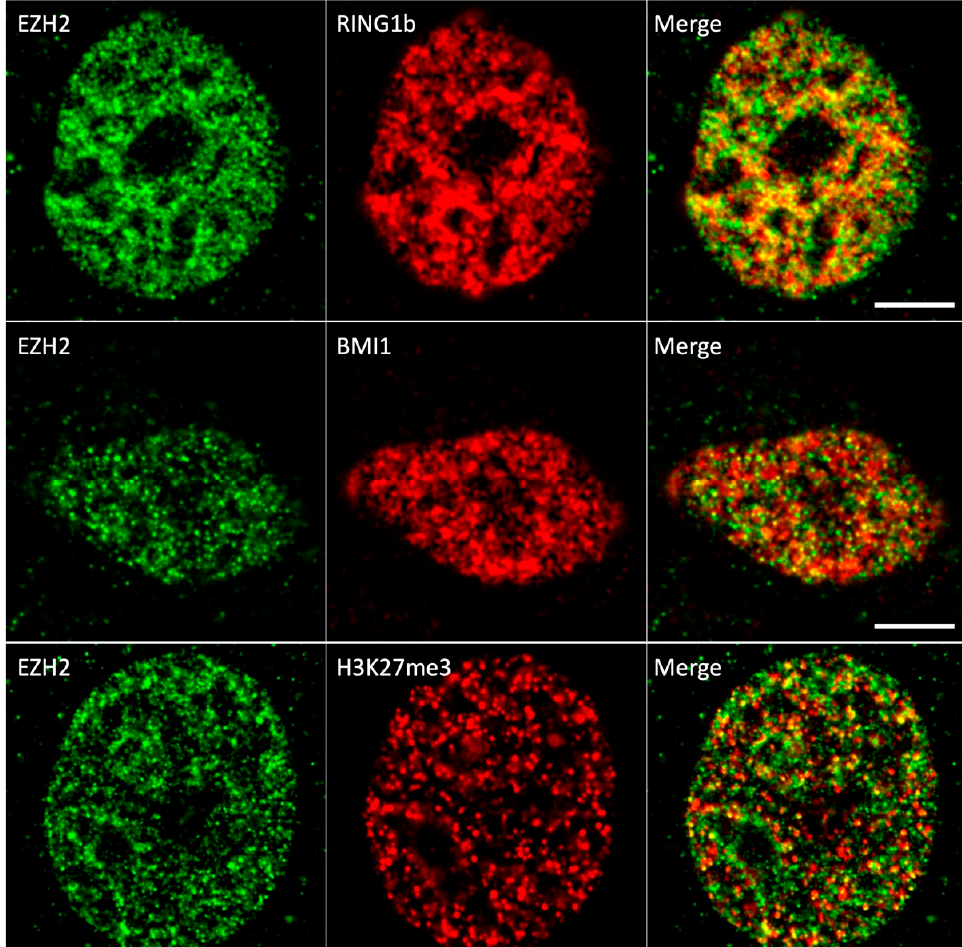
Figure 3. PR-ISM images of HCC827 nuclei immunolabeled by EZH2/RING1b (upper row), EZH2/BMI1 (central row), and EZH2/H3K27me3 (lower row). For all images, the background was subtracted by a rolling ball algorithm. Scale bar: 10 µm.